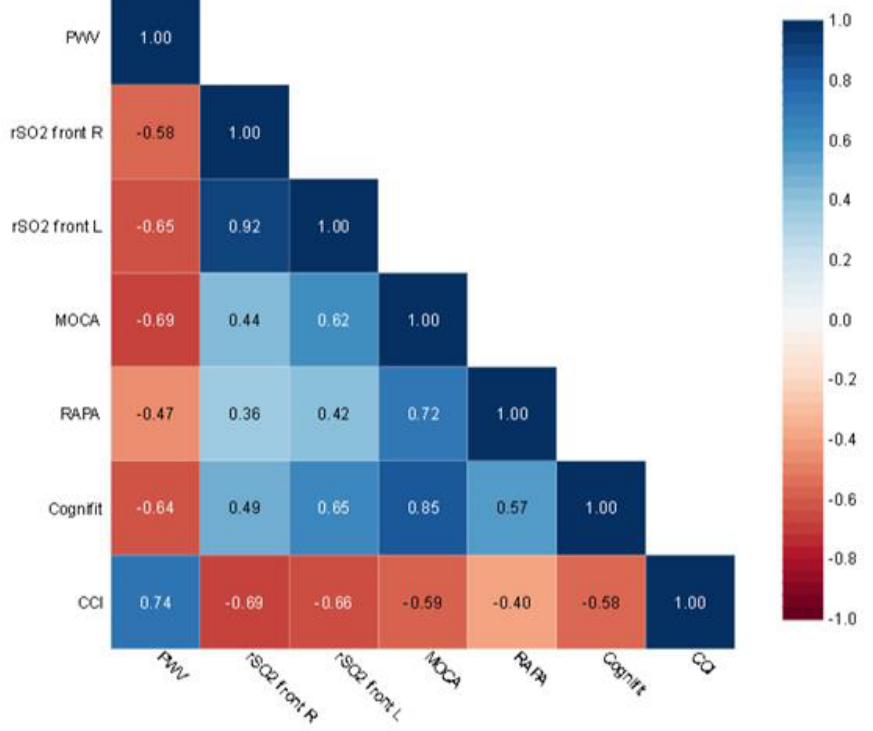
Figure 3. Correlation of the CompBased-CAT (Cognifit score) with rSO2 front R, rSO2 front L, PWV, and CCI.